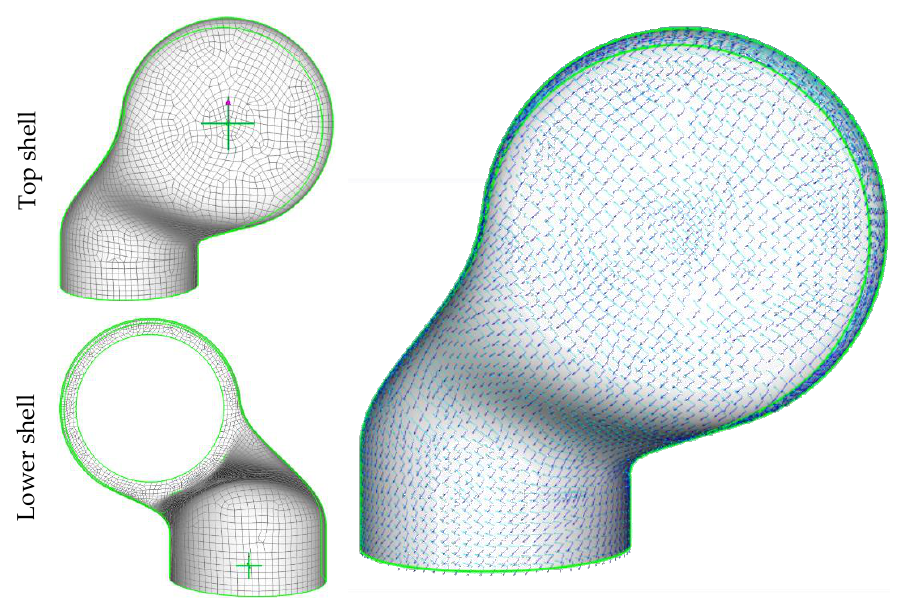
Figure 5. Procedure and result of the kinematic drape simulation for the as-planned configuration.